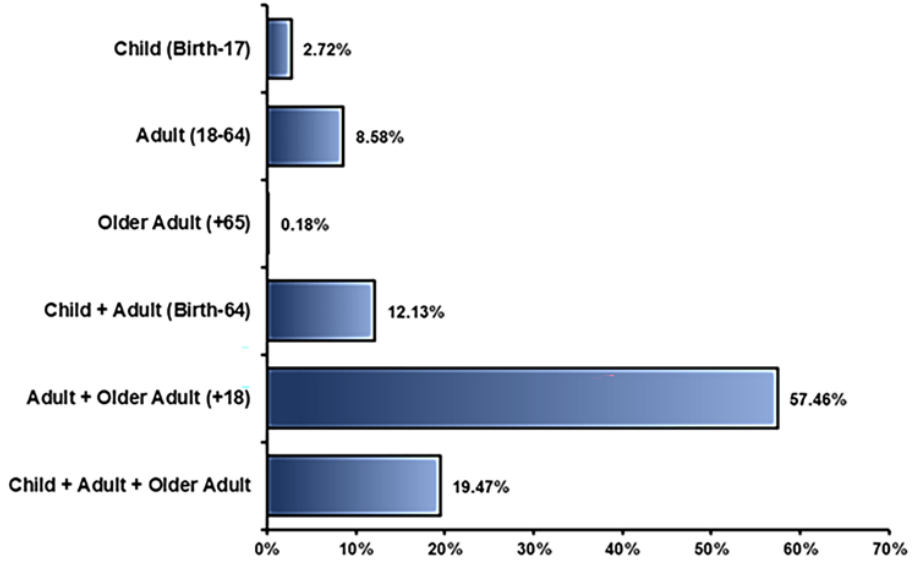
Figure 7. The age of patients participating in clinical trials using stem cells.